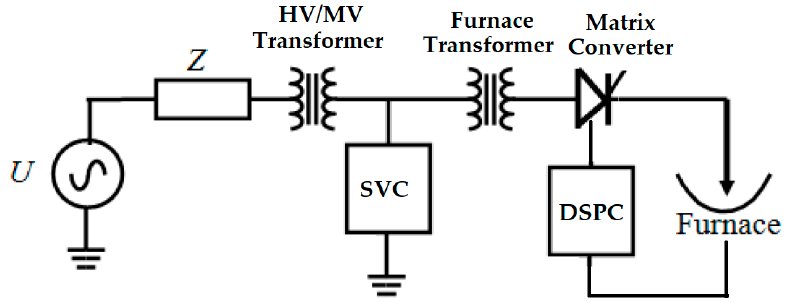
Figure 1. Proposed Figure 1. Proposed model.